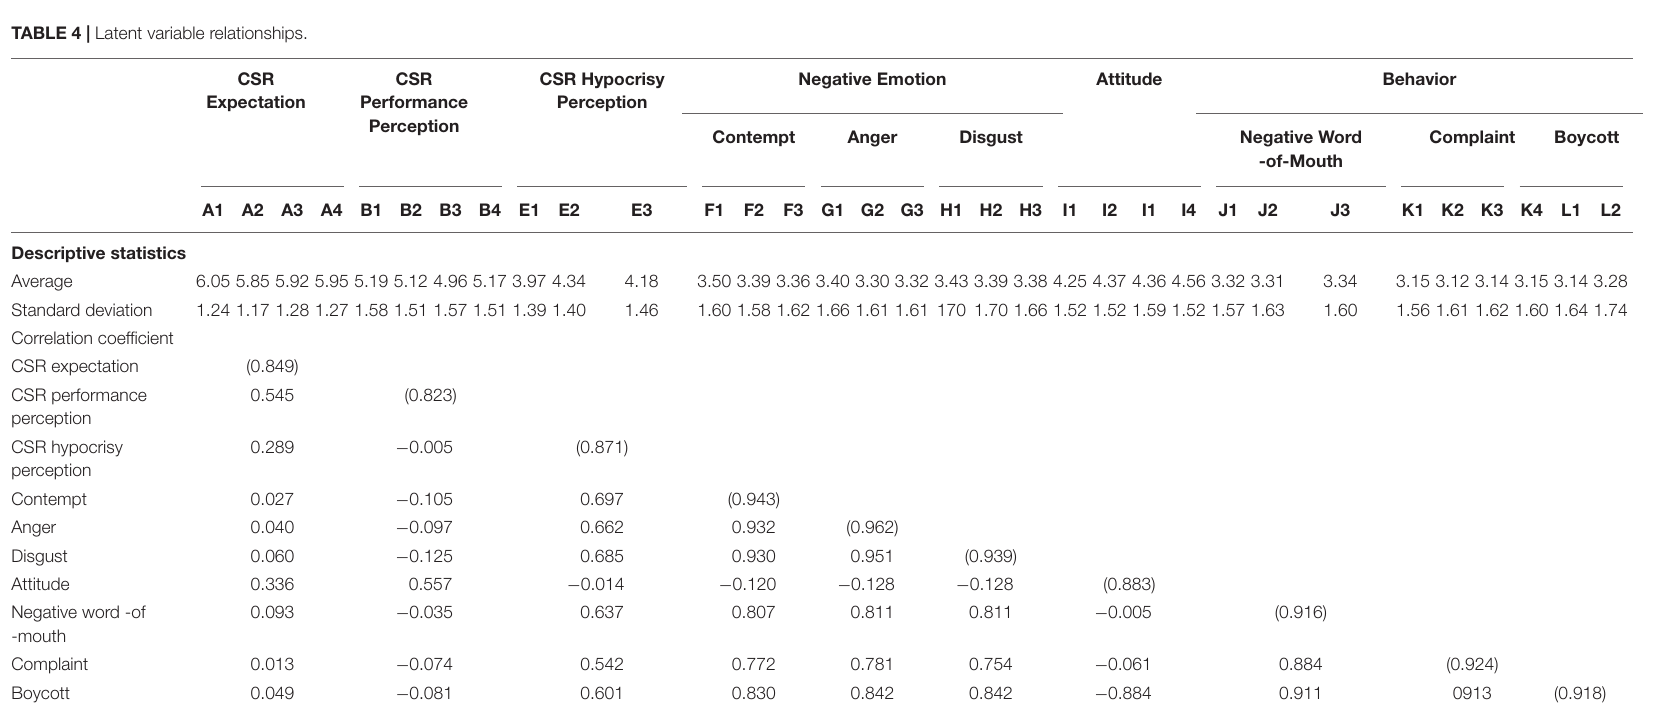
Diagonal data are the square roots of the